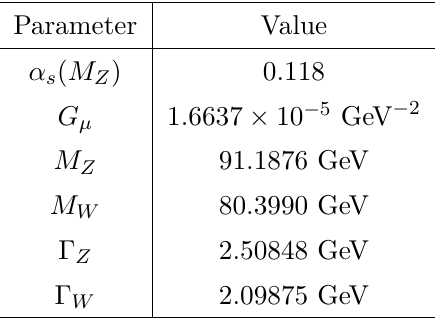
Table 2 . Parameters used in the Monte Carlo generation of pp → t ¯ tj → W + W − b ¯ bj . The elec- tromagnetic coupling α and the weak mixing angle θ W are computed in the G µ scheme